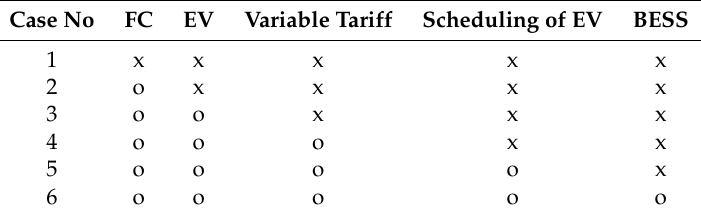
Table 2. Description of the test cases.